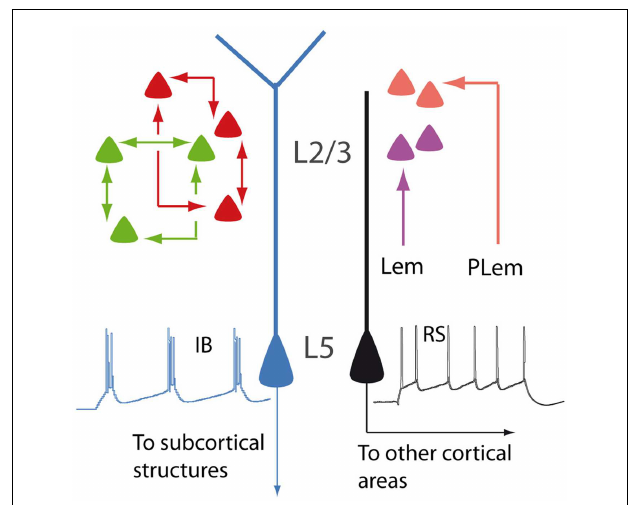
FIGURE 1 | Schematic illustration showing different types of PNs . In layer 2/3, neurons are interconnected to form distinct subnetworks (green and red cells). In the barrel cortex, lemniscal (Lem) and paralemniscal (PLem) afferents target different subpopulations (purple and orange cells). In layer 5, regular spiking PNs (RS, black) and intrinsically bursting PNs (IB, blue) display different dendritic morphologies and different projections.